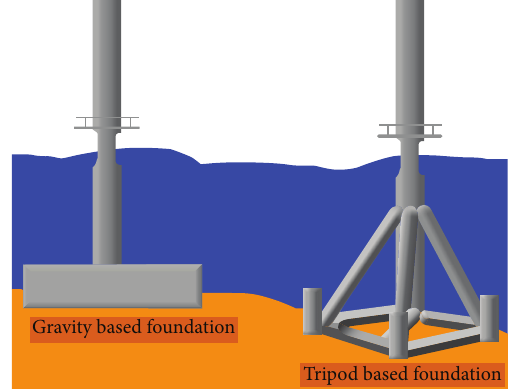
Figure 2: Gravity based and tripod foundation concepts [4].